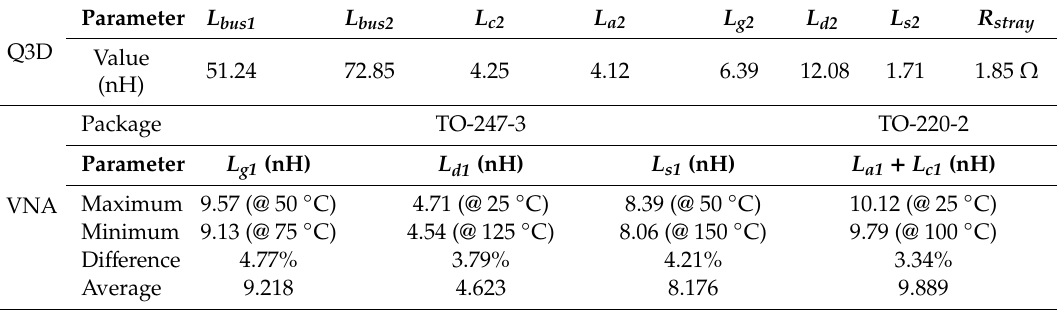
Figure 8. Measured scatters and fitted curve of the key parameters. ( a ) Trans-conductance g f , ( b ) on-state resistance R on , ( c ) threshold voltage v th and forward voltage v f , ( d ) junction capacitance of silicon carbide (SiC) Schottky diode (SBD) C f , ( e ) output capacitance C oss and reverse transfer capacitance C rss , ( f ) internal resistance R g-int and R f . Table 2. Extraction results of the stray and parasitic